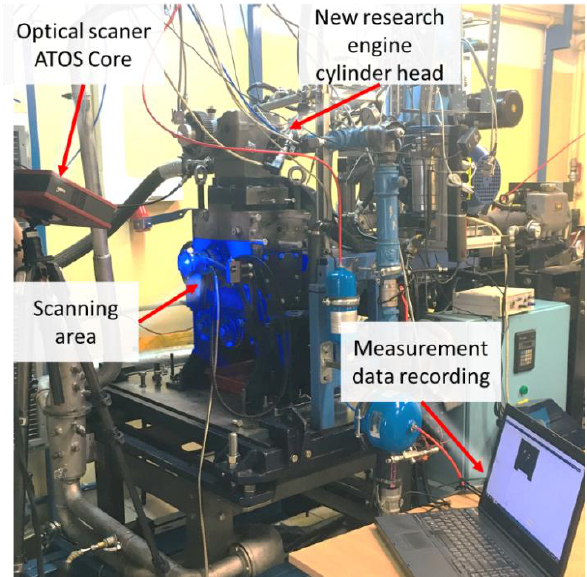
Fig. 8. Optical scanning process of area of driveline